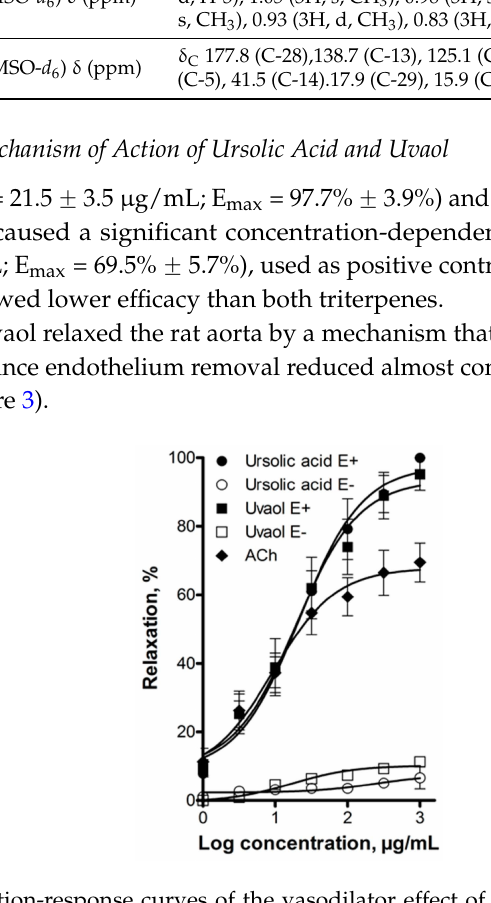
Figure 3. Concentration-response curves of the vasodilator effect of ursolic acid and uvaol in the presence (E+) and absence (E ´ ) of endothelium. Acetylcholine (ACh) was used as positive control. Analysis by repeated-measures two-way ANOVA was made between the curves of each triterpene in the presence and absence of endothelium ( p <